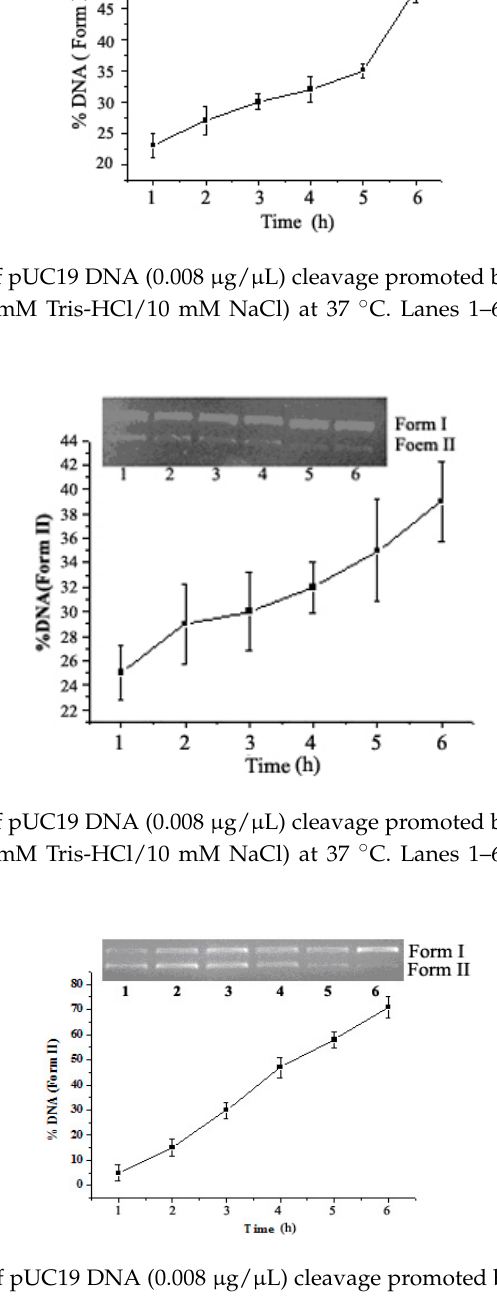
Figure 7. Time course of pUC19 DNA (0.008 µg/µL) cleavage promoted by 2c (3.13 × 10 − 7 mol/L) in pH = 6.0 buffers (5 mM Tris-HCl/10 mM NaCl) at 37 °C. Lanes 1–6, 6, 5, 4, 3, 2, 1 h reaction time, respectively.